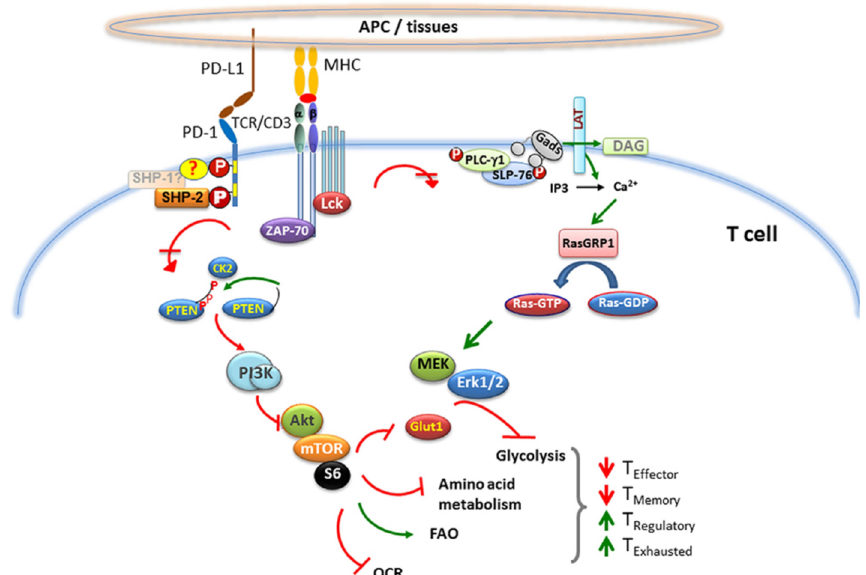
Figure 1. Pathophysiology of PD-1. CK2: casein kinase-2; DAG: diacylglycerol; FAO: fatty acid oxidation; Gads: GRB2-related adaptor downstream of Shc; GDP: guanosine diphosphate; Glut1: glucose transporter 1; GTP: guanosine triphosphate; IP3: inositol 1,4,5-trisphosphate; MEK: mitogen-activated protein kinase kinase; OCR: oxygen consumption rate; P: phosphorylated; PI3K: phosphoinositide 3-kinase; PLC-γ1: phospholipase C-gamma 1; PTEN: phosphatase and tensin homolog; RasGRP: Ras guanil releasing protein; LAT: linker for activation of T cells; SLP-76: SH2 domain-containing leukocyte phosphoprotein of